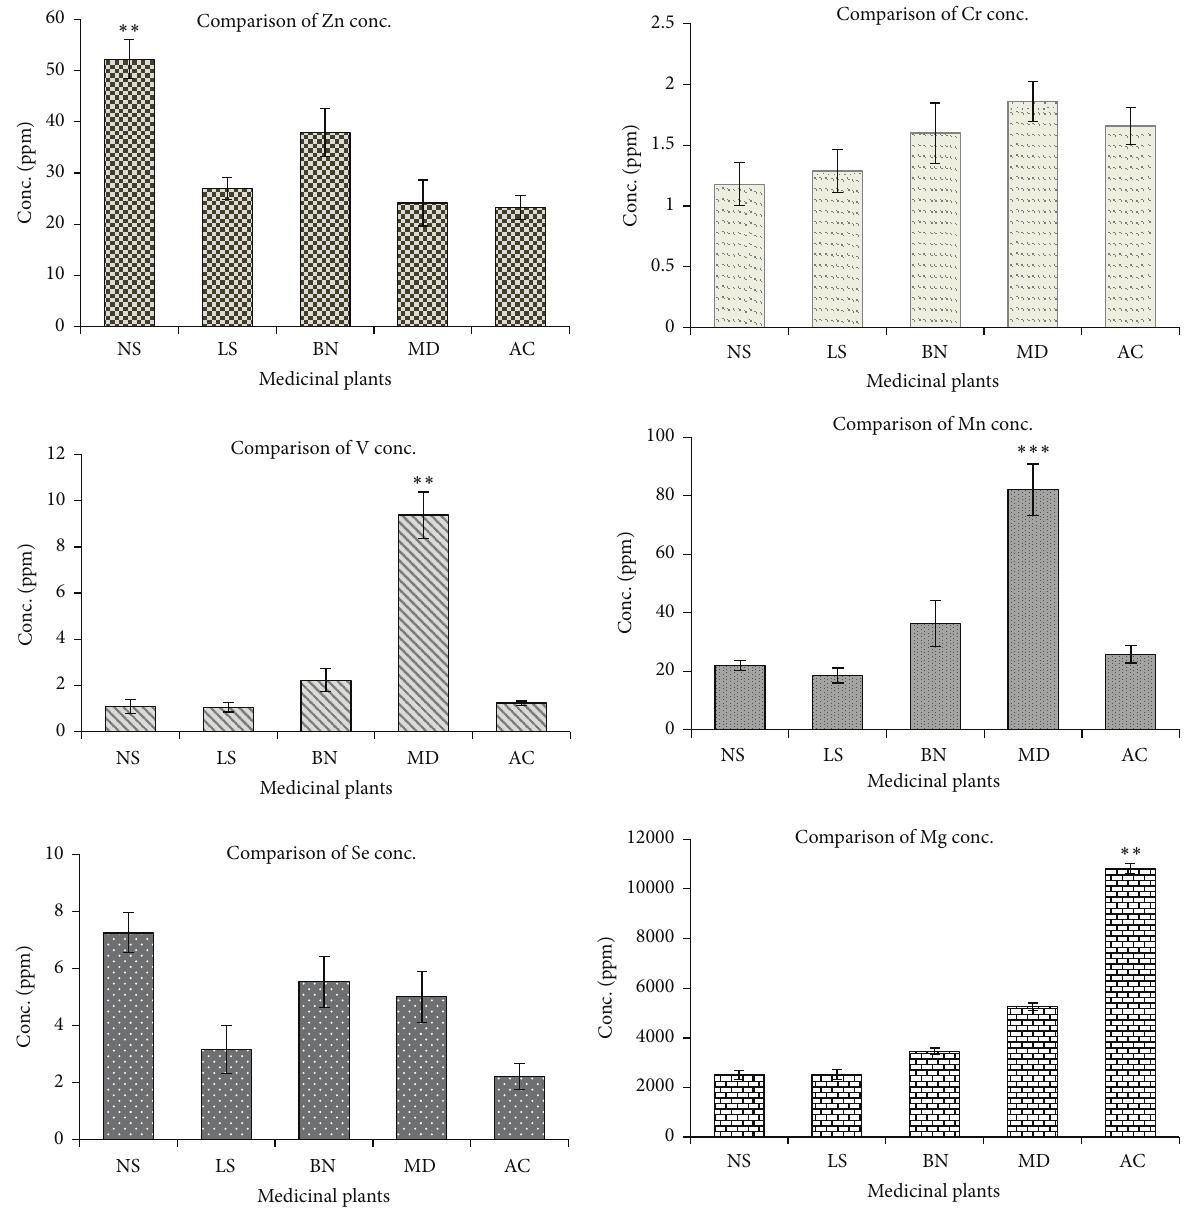
Figure 2: Comparison of the levels of Zn, Cr, V, Mg, Mn, and Se among the plants. ∗∗∗ 𝑃 < 0.001 and ∗∗ 𝑃 < 0.01 represent statistical significance of the level of the element in one plant relative to the